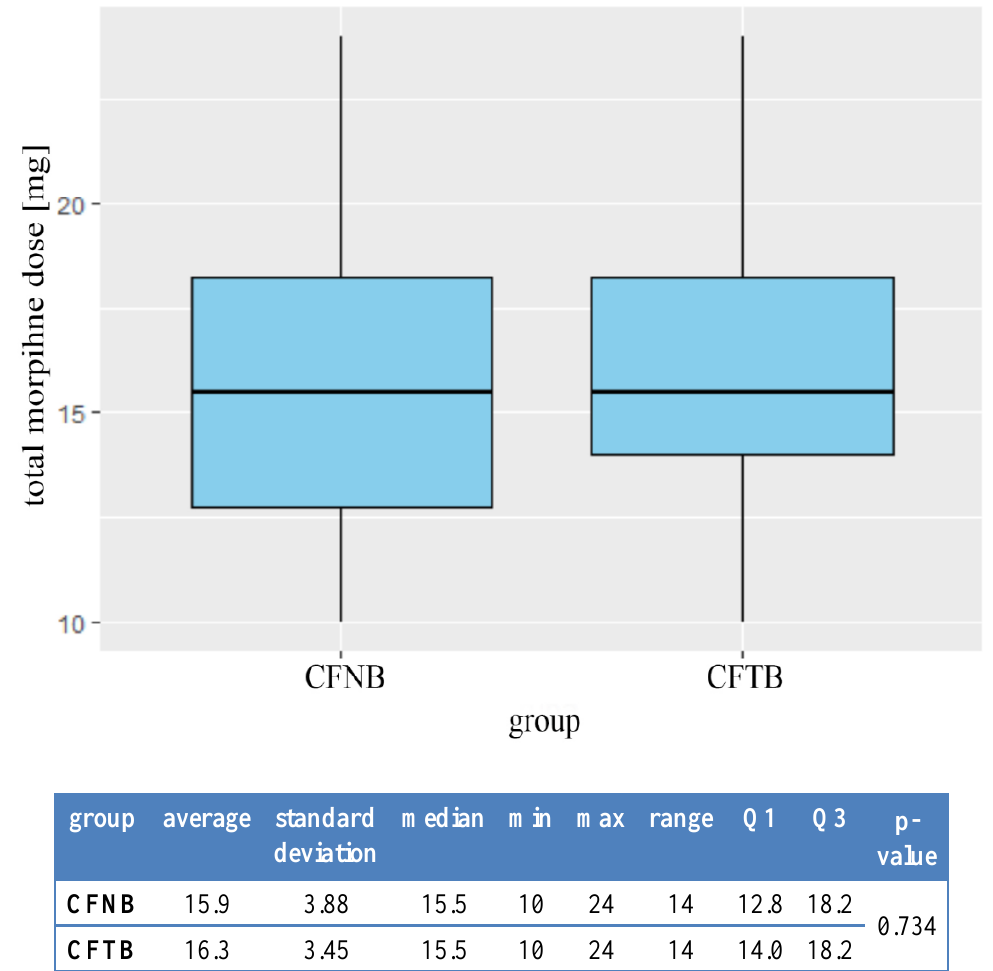
Figure 5. Evaluation of opioid consumption in the groups. Morphine dose in mg.